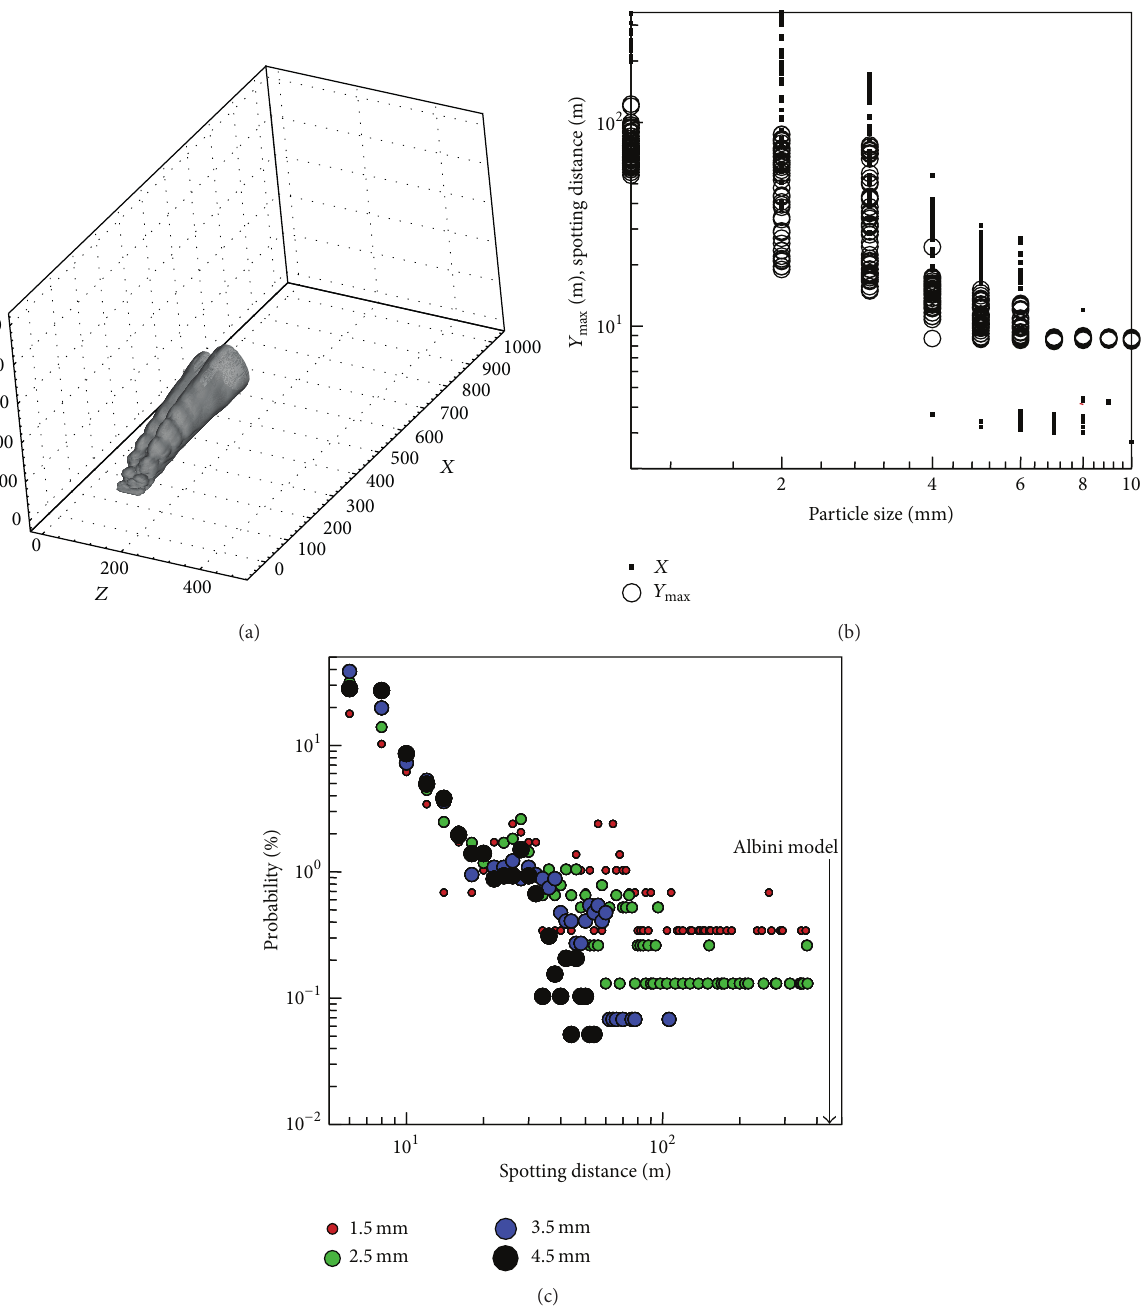
Figure 6: (a) Smoke scalar concentration for 20000 kW/m short grass fire; (b) maximum height and longitudinal distances during particle trajectory as a function of particle size; and (c) probability of particles spotting distances as a function of particle